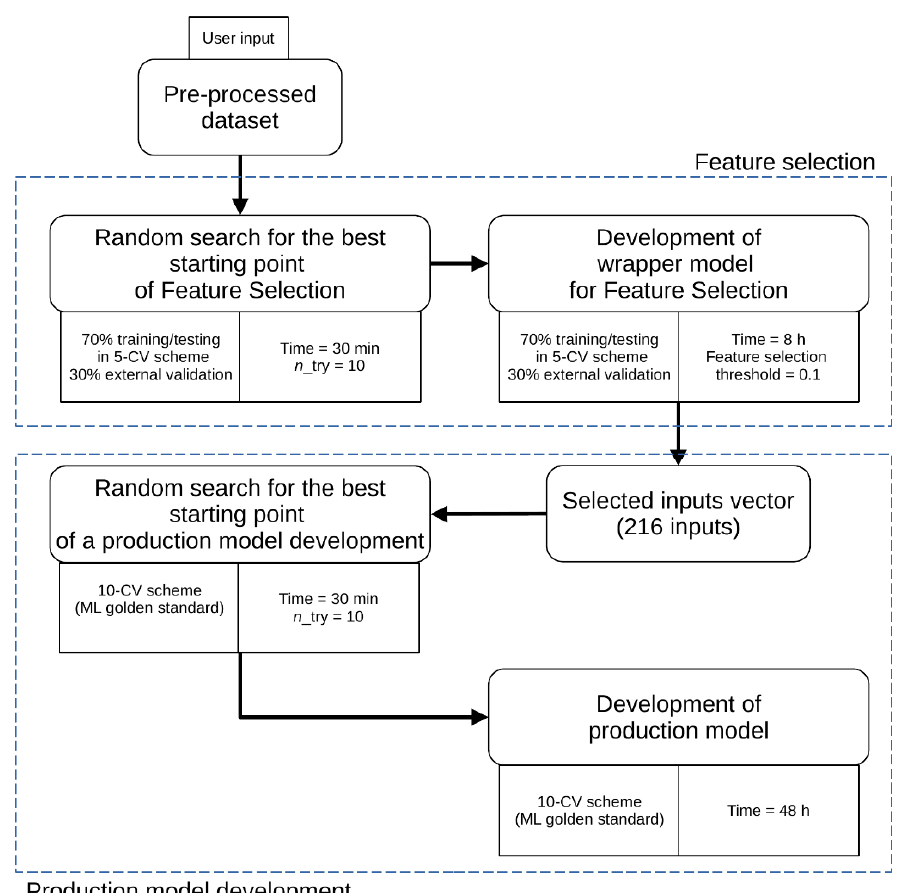
Figure 1. Scheme of applied AutoML H 2 O workflow.